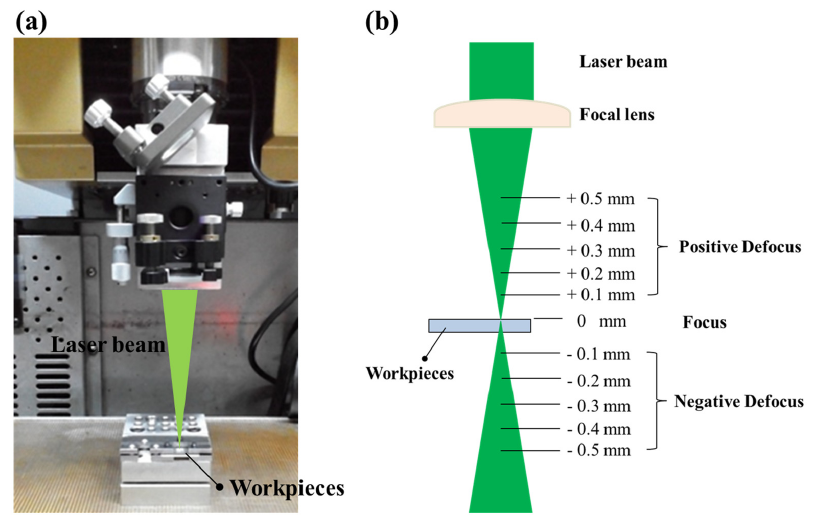
Figure 8. Laser processing experiment ( a ) laser mechanism ( b ) laser beam in different focusing arrangements.